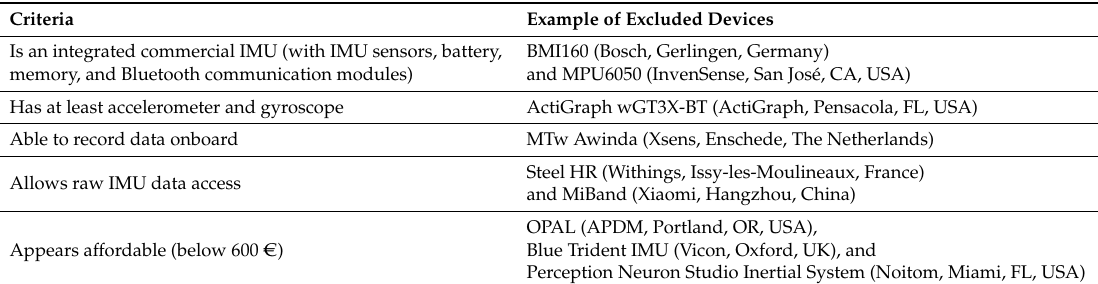
Table 3. Selection criteria and example of excluded IMU